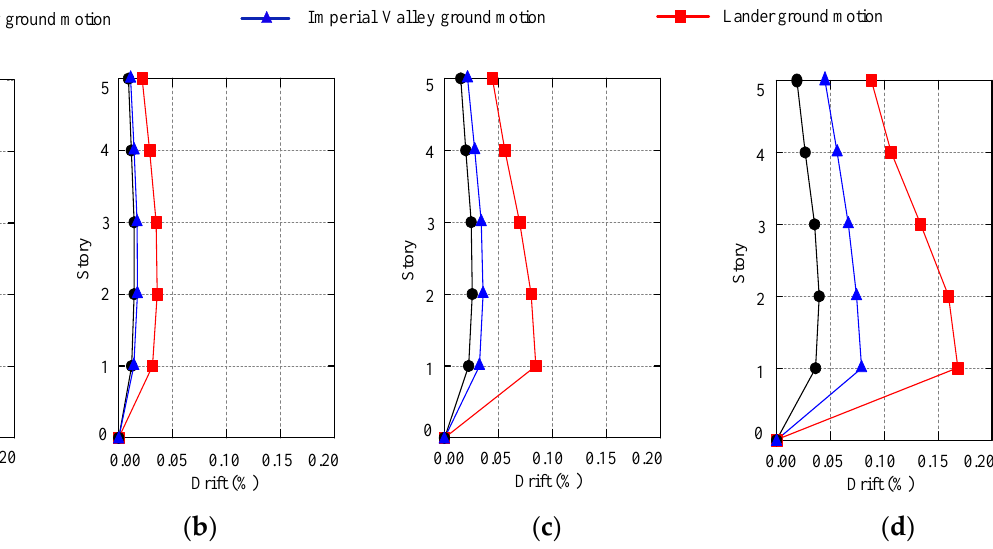
Figure 12. The maximum inter-story drift ratio of stories under different ground motions. ( a ) PGA